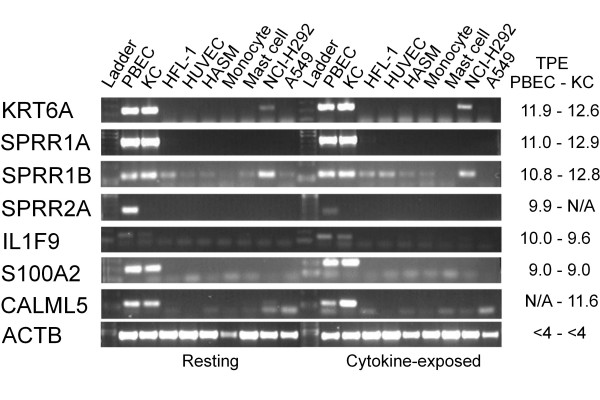
PCR verification of 7 potential preferentially expressed tags identified using the TPE algorithm. The expression of these seven genes was assessed both under resting conditions and after cytokine exposure in all cell types. On the right, the TPE values of the gene are listed for both PBEC and KC after cytokine exposure. Tags for which no TPE value could be calculated because of absence of the tag in the particular library are indicated by "not available" (N/A). The predicted preferential expression could be verified for all genes. The expression of six of these genes seems to be selective for epithelial cells only. Whereas SPRR1B is preferentially expressed by epithelial cells, moderate to low levels of expression were also detected in other cell types as well. SPRR2A is preferentially expressed by PBEC only. No tags for SPRR2A were found in the KC libraries after TNFα exposure whereas expression for CALML5 was observed by RT-PCR in both PBEC and KC, while no tags for this gene were found in PBEC libraries.